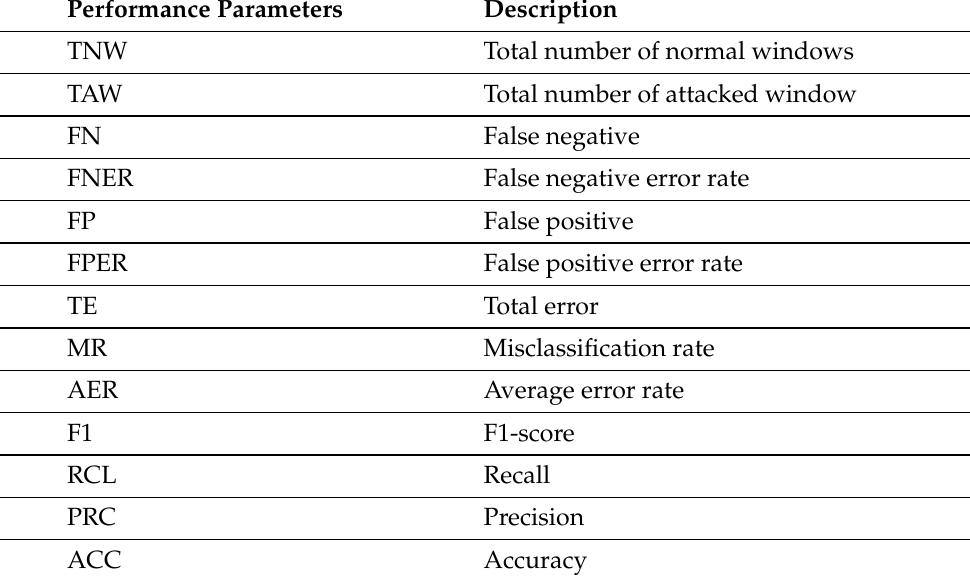
Table 3. Performance